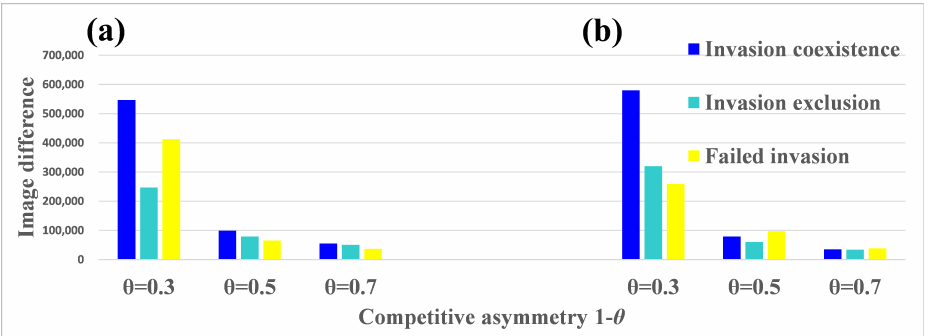
Figure 7. Comparison of competitive invasion results in case 2. ( a ) suggests the mean difference of each type of invasion consequence across the scenarios when invaders only competing with one resident species. ( b ) represents the mean gap of each invasion consequence over the scenarios when invaders competing with two of native species. We quantify the comparison by image difference of invasion consequence regions (region details as shown in Supplementary information). It is calculated by counting the number of pixels at the same competitive asymmetry level and calculating the difference and average value of the pixel number. We assume competing force α 14 = α 24 or α 14 = α 34 or α 24 = α 34 . Bars with different colors are for different invasion consequences. Competitive asymmetry 1 − θ = 1 − 0.3 or 1 − 0.5 or 1 − 0.7. Other parameter values are the